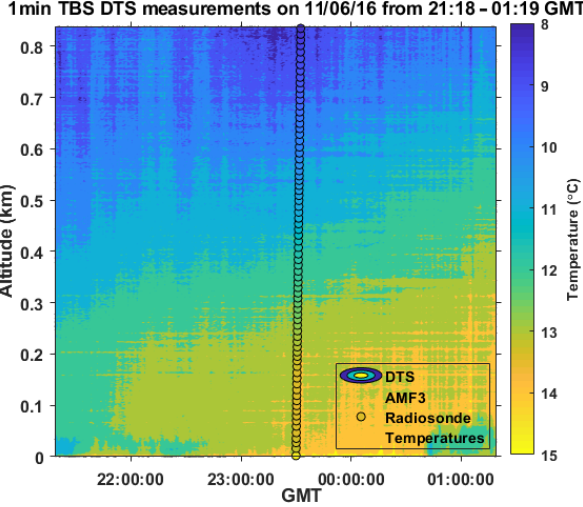
Figure 15. TBS DTS measurements collected once per minute with concurrent free-balloon radiosonde launch at